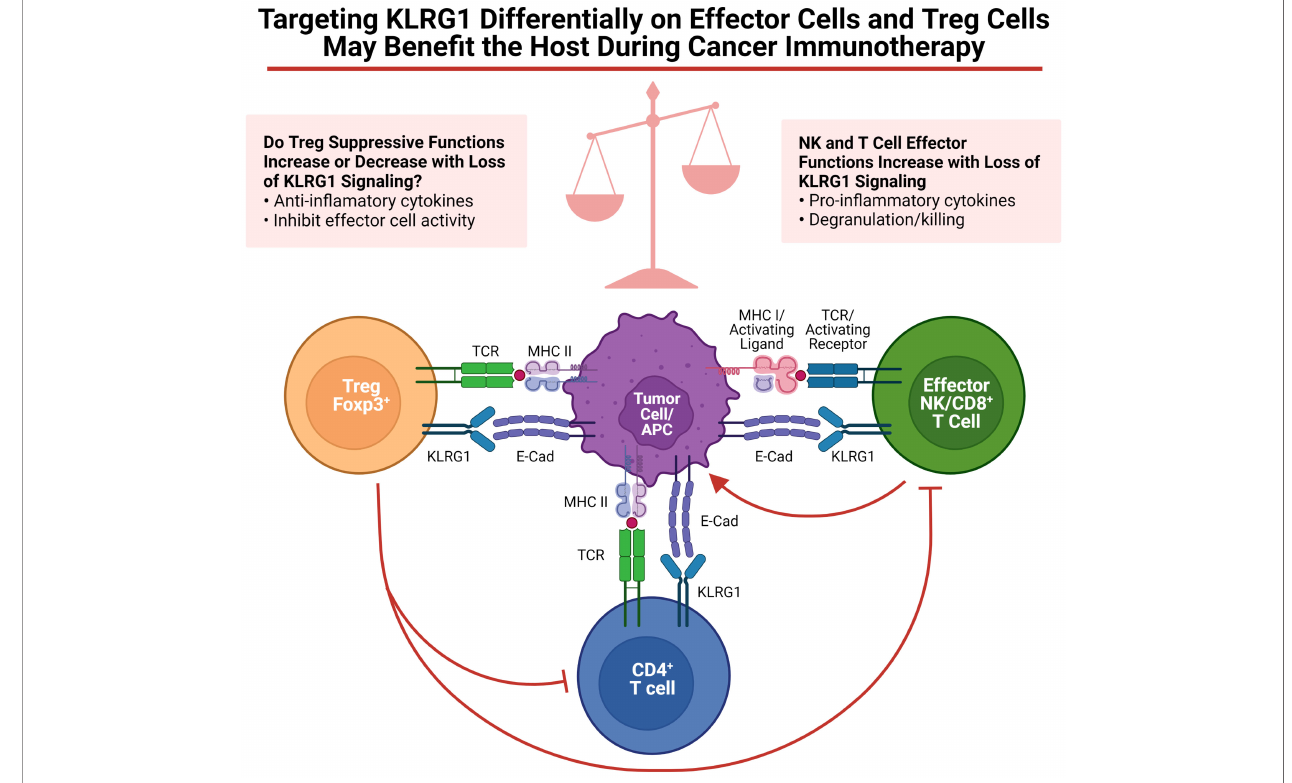
FIGURE 1 | Targeting KLRG1 differentially on effector cells and Treg cells may bene fi t the host during cancer immunotherapy. Functions of KLRG1 signaling on various effector cells as well as Tregs are summarized. Figure was created on